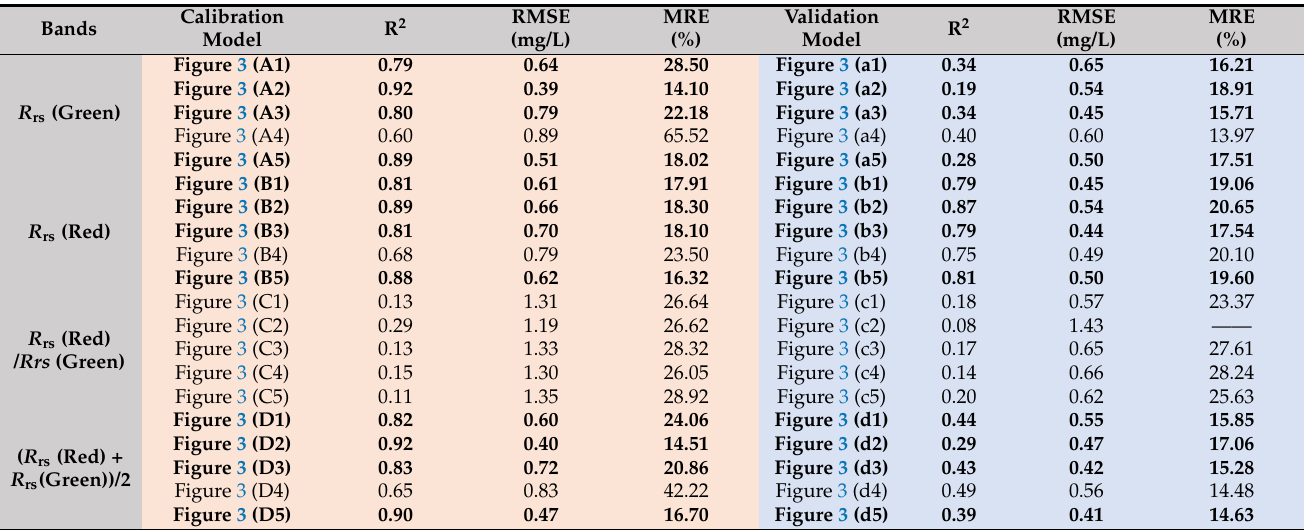
Table 3. The calibration and validation of TSM modeling. A1–D5 and a1–d5 represent different calibration models and validation models in Figure 4. R 2 , RMSE, and MRE stand for the coefficient of determination, root mean square error, and mean relative error.